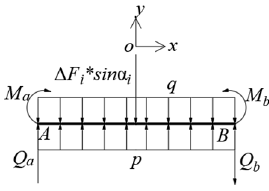
Figure 2. Microsegment diagram of girder subjected to force.